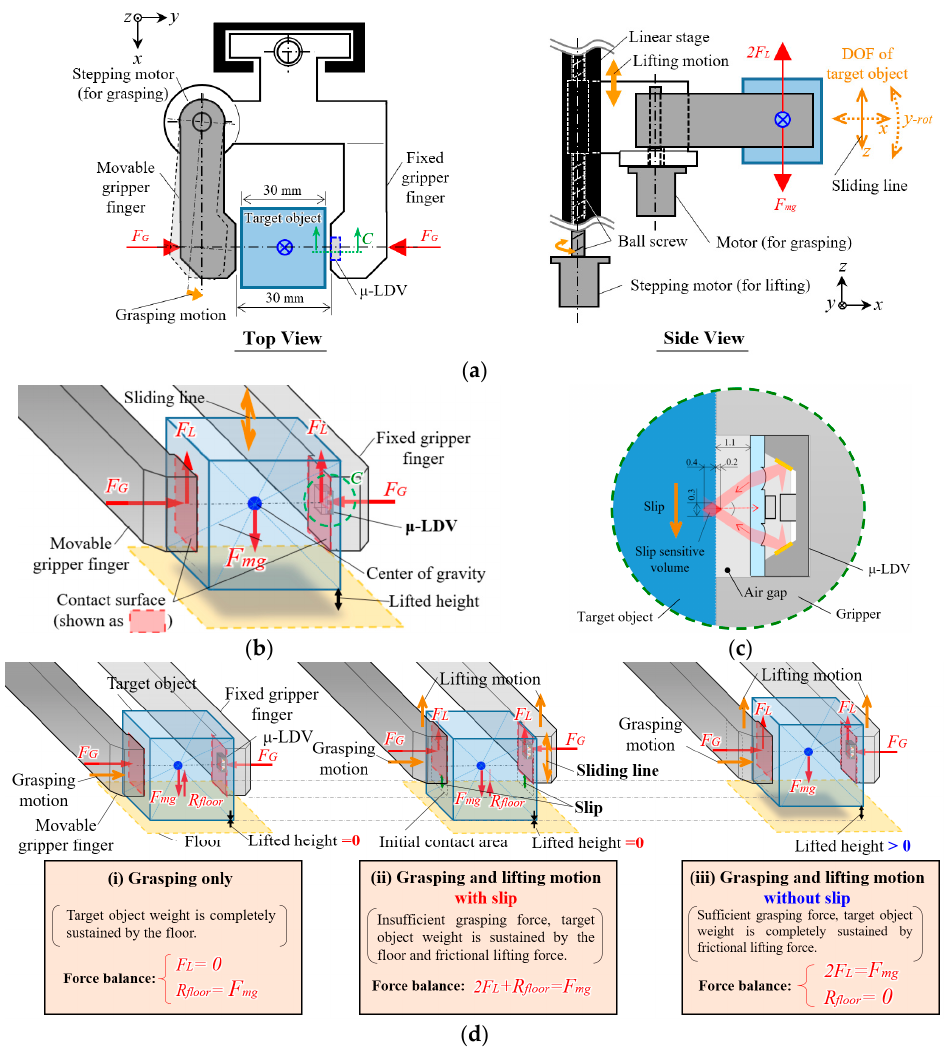
Figure 5. Grasping model: ( a ) Mechanical model of grasping. ( b ) Schematics of description of contact surfaces and force balance in grasped condition. ( c ) Description around slip detection sight (“C” shown in ( a , b )). ( d ) Force balance, sliding line, and direction of grasping motion and lifting motion around a target object in the model in ( i ) only grasping, ( ii ) grasping and lifting motion with slip, and ( iii ) grasping and lifting motion without slip.